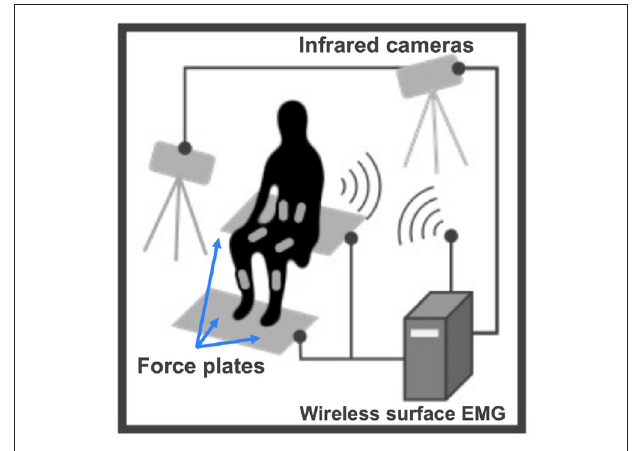
FIGURE 4 | STS measurement experiment